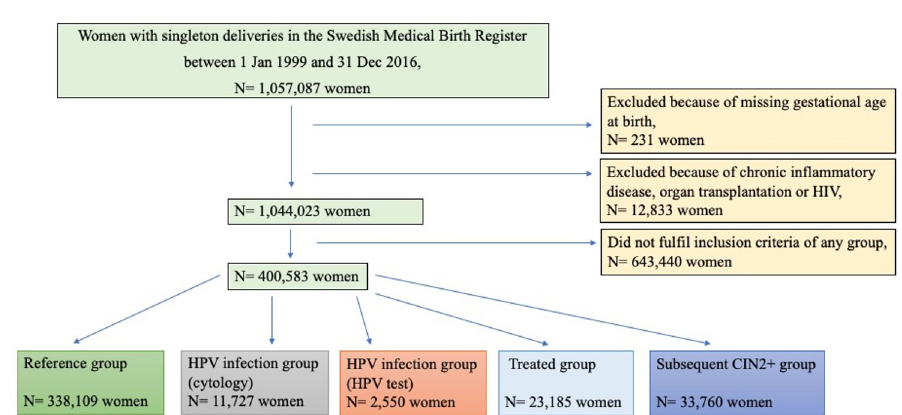
Fig 1. Flowchart of the study population. AU : singletonismisspelledinFig 1 : Pleasefix : CIN, cervical intraepithelial neoplasia; HIV, human immunodeficiency virus; HPV, human papillomavirus.